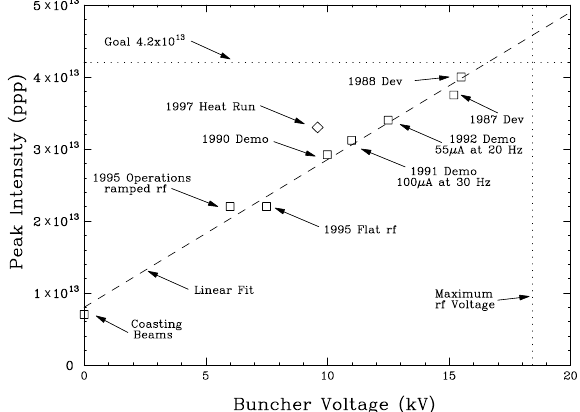
FIG. 1. Maximum stable stored beam intensity as a function of rf bunching